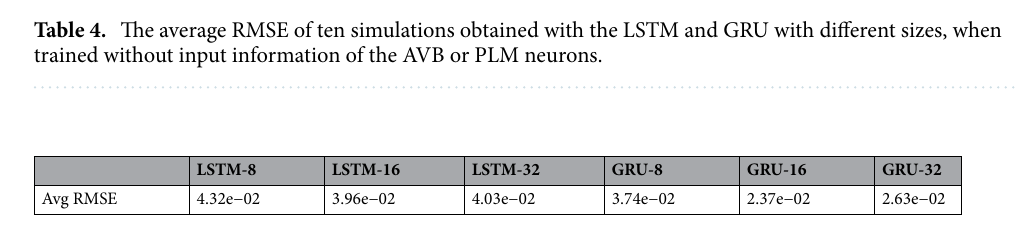
Table 5. The average RMSE of ten simulations for the dataset replicating the FCM and Nictation behaviours.